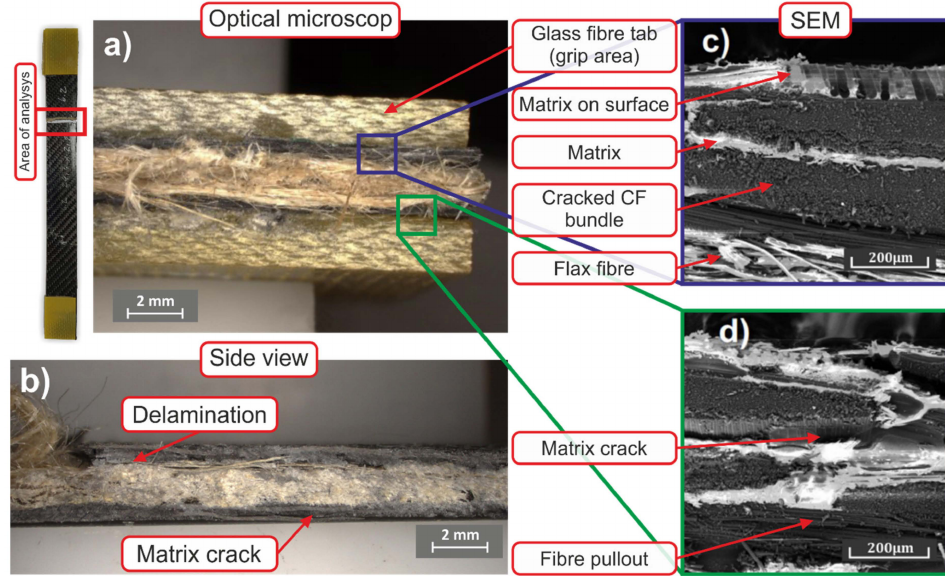
Figure 14. Microstructure of cracked tensile test sample—optical microscopy and SEM analysis, ( a ) top view, ( b ) side view ( c ) SEM image fracture area carbon–flax, ( d ) SEM image carbon